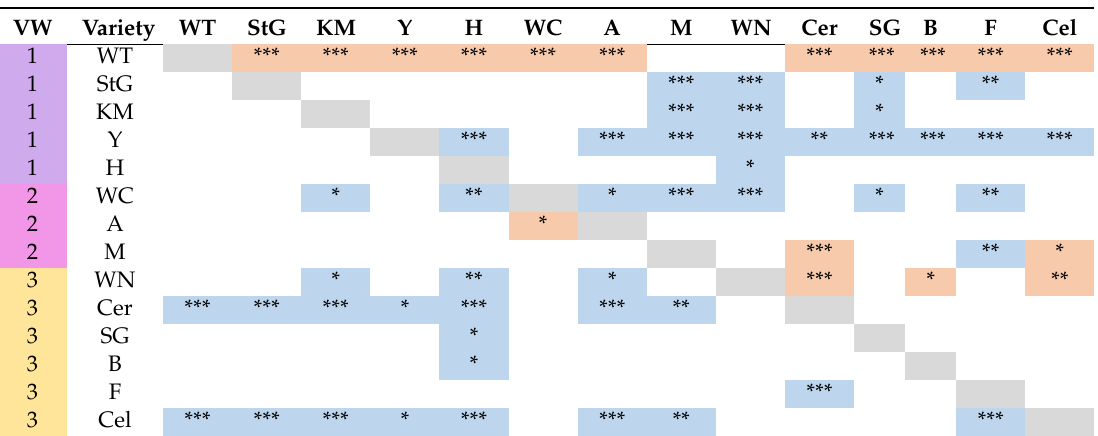
Table 1. Comparison of average total polyphenols in hop roots before flowering (BBCH stage 51–55; table—top triangle above grey-boxed area) and at the mature cones stage (BBCH stage 87–89; table—bottom triangle below grey-boxed